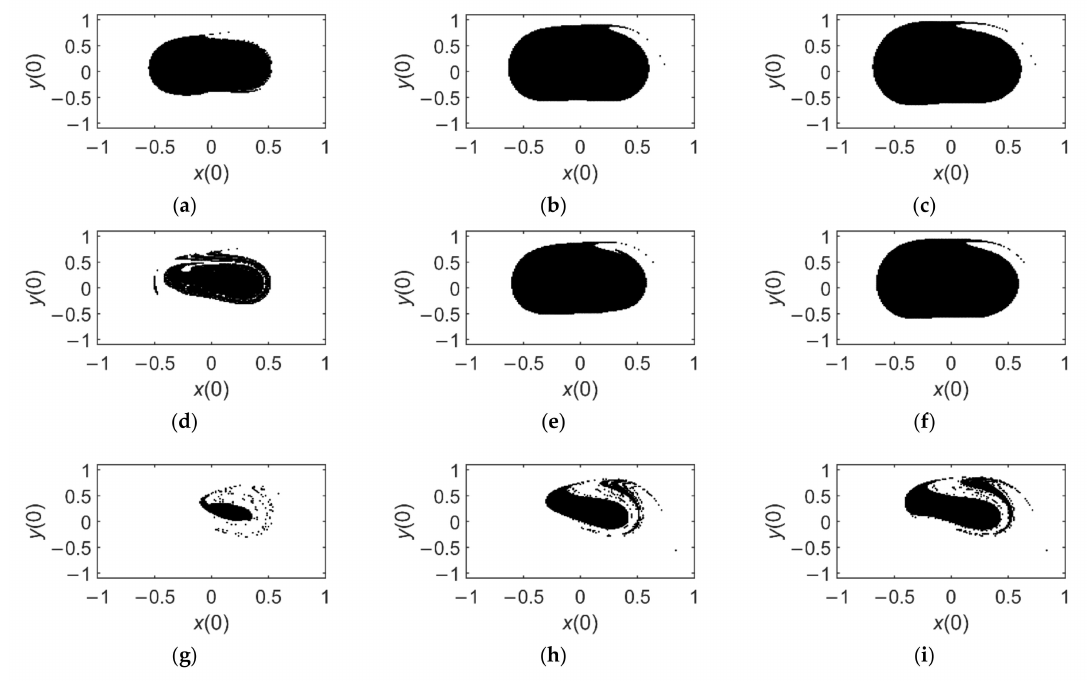
Figure 12. Safe basins of the controlled system (39) under different values of V AC and τ